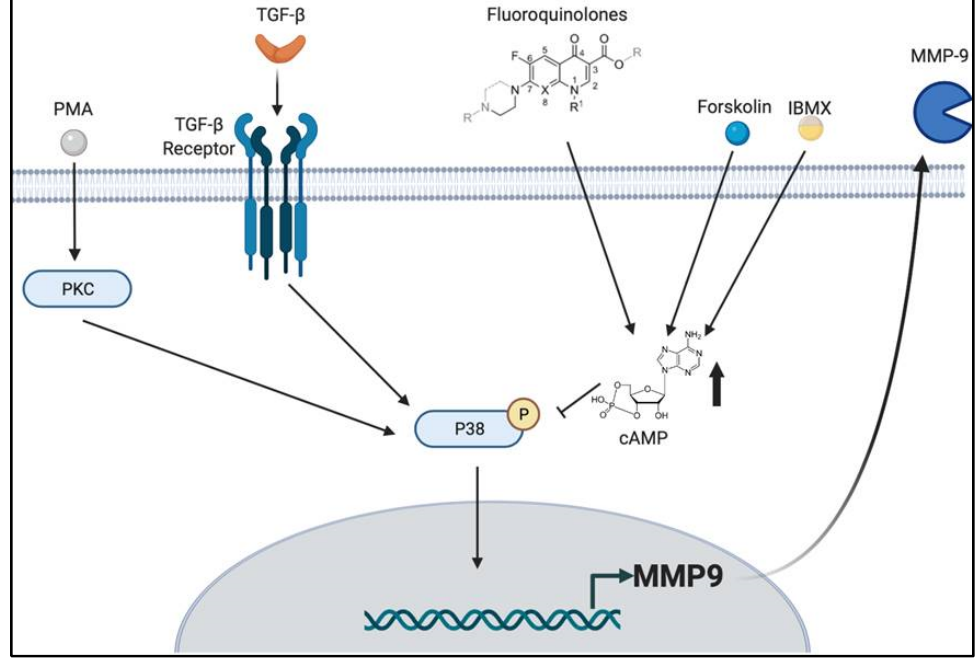
Figure 8. The model by which fluoroquinolones (FQs) inhibit matrix metalloproteinase-9 (MMP-9) production by modulating p38 and cyclic AMP (cAMP) signaling. In epithelial cells, transforming growth factor beta (TGF- β ) promotes invasion and metastasis (100% growth inhibition at 200 pM) by stimulating the p38-mediated signaling cascade in concert with canonical TGF- β signaling mediated by TGF- β receptor I (T β R-I) and T β R-II (T β R-I/T β R-II/Smad-2/3/4). It has been recognized that FQs exert their anti-inflammation by producing intracellular cAMP, and we discovered that FQs antagonize TGF- β and phorbol 12-myristate 13-acetate (PMA)-induced MMP-9 production by suppressing phosphorylation of p38 via cAMP production or via their components.